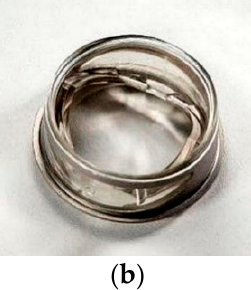
Figure 9. Polymer components of the valve rings: ( a ) the inflow and ( b ) outflow valve.